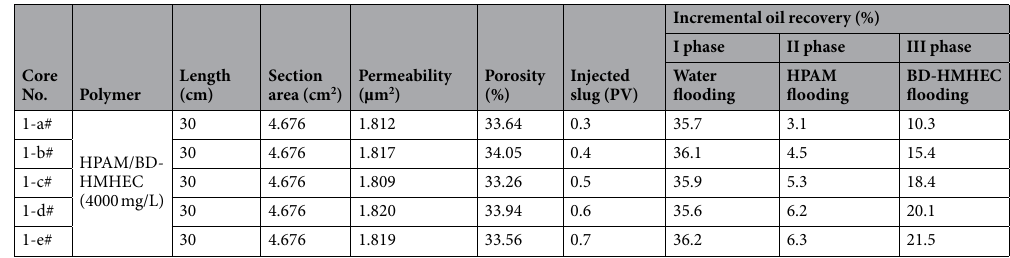
Table 1. The results of HPAM and BD-HMHEC flooding after water flooding (injection rate: 0.5